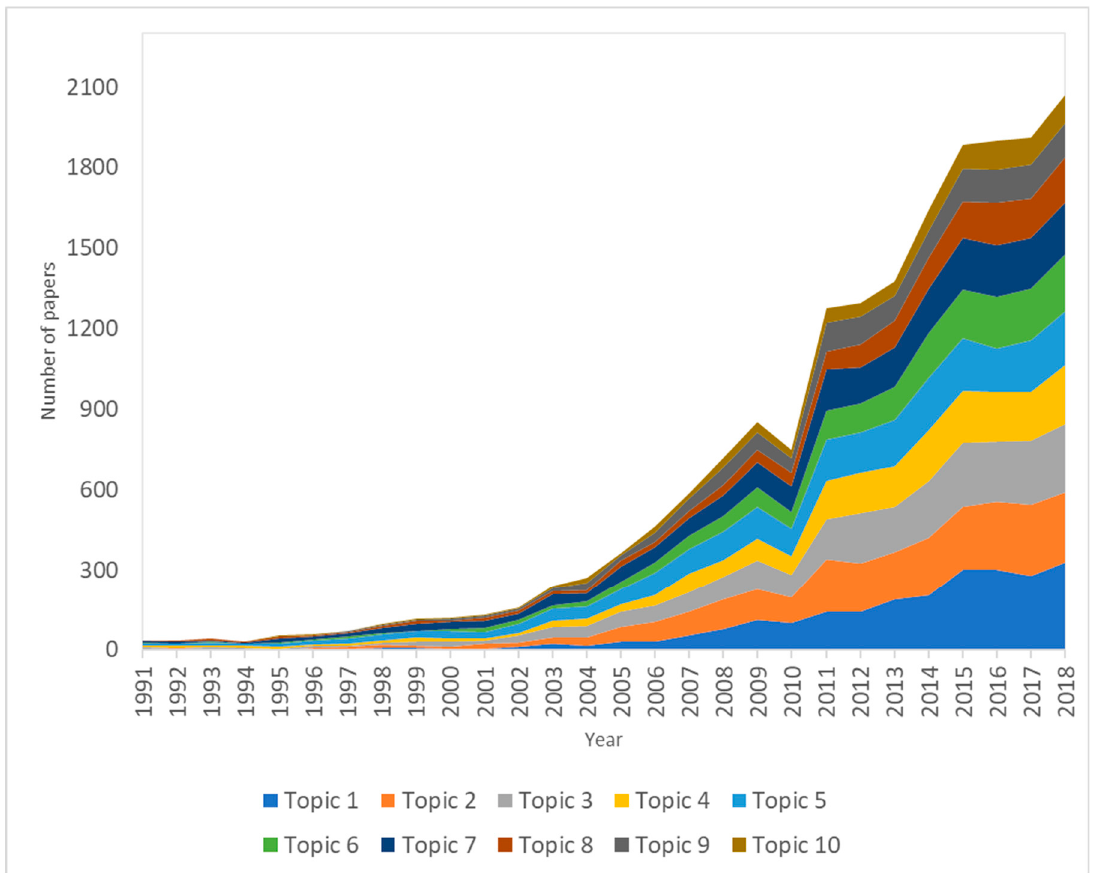
Figure 1. Changes in research topics development in obesity interventions among children